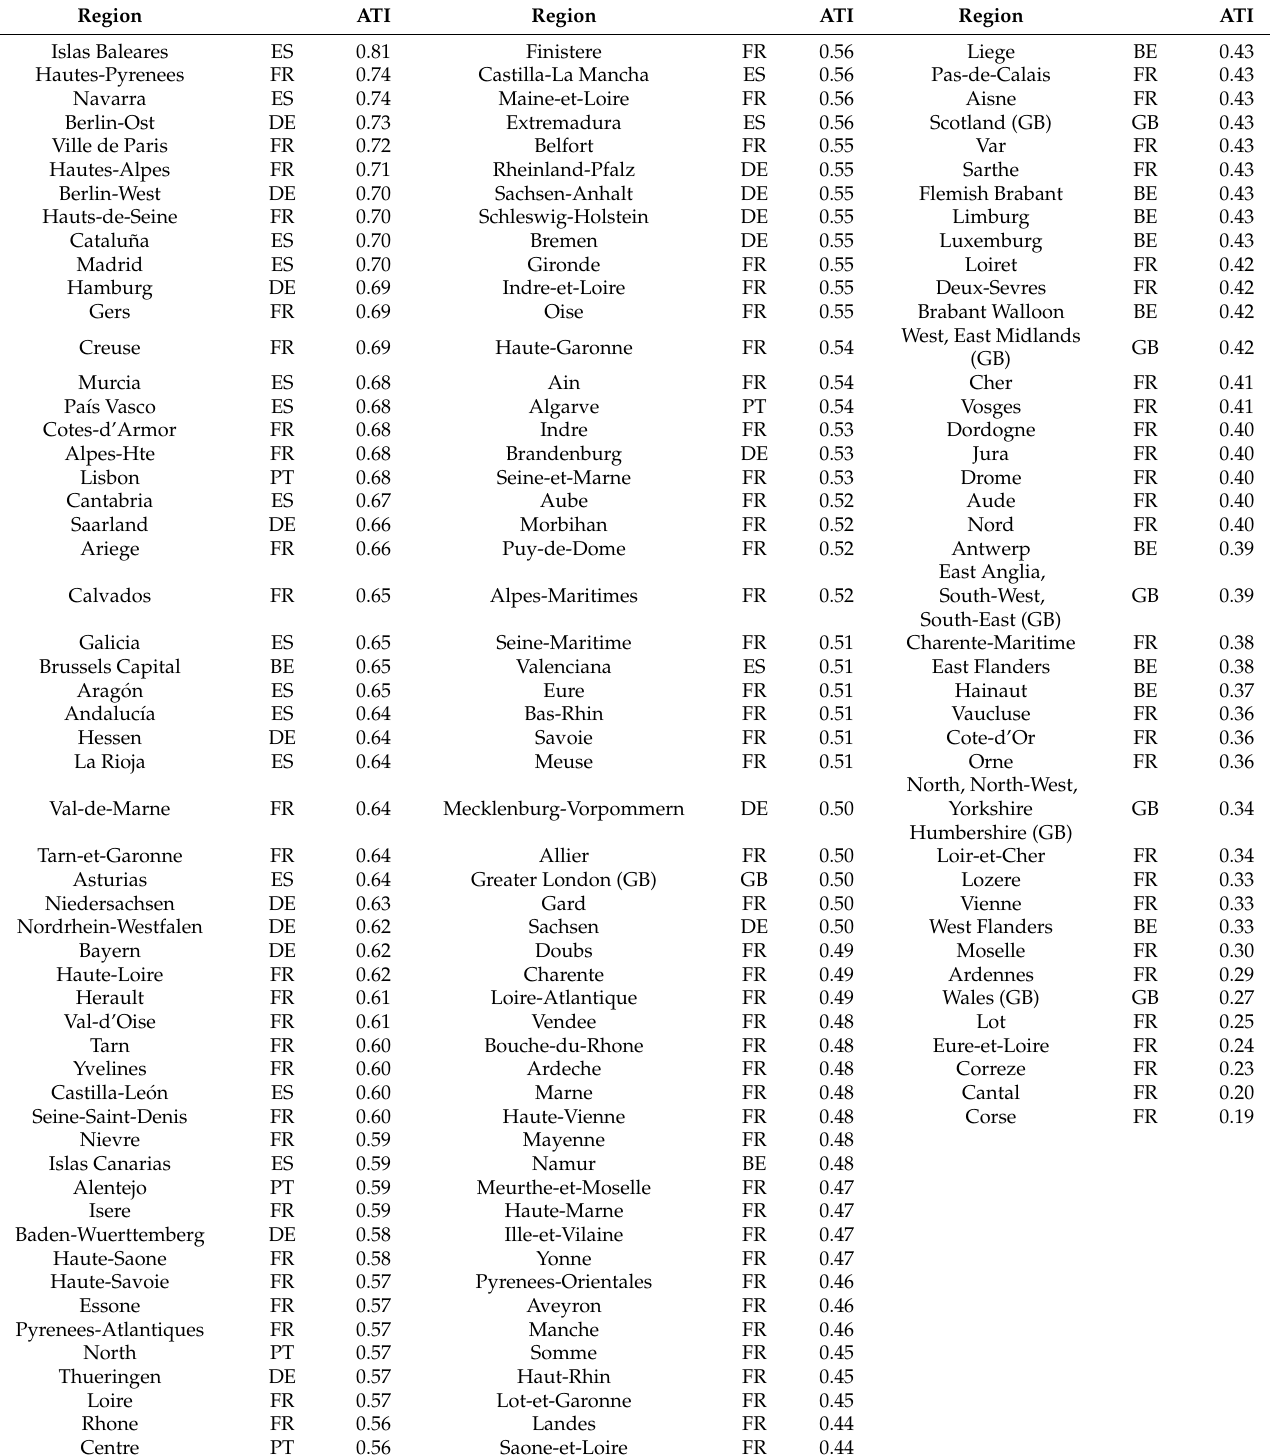
Table 4. Regional